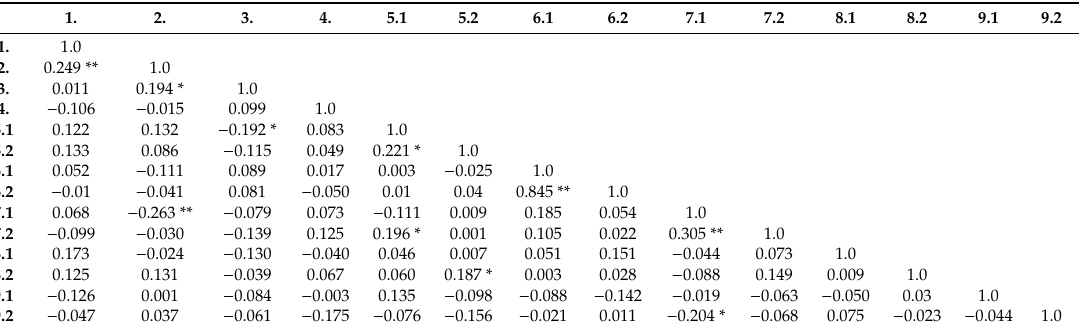
Table 2. Pearson correlation matrix of descriptive criteria of business model.